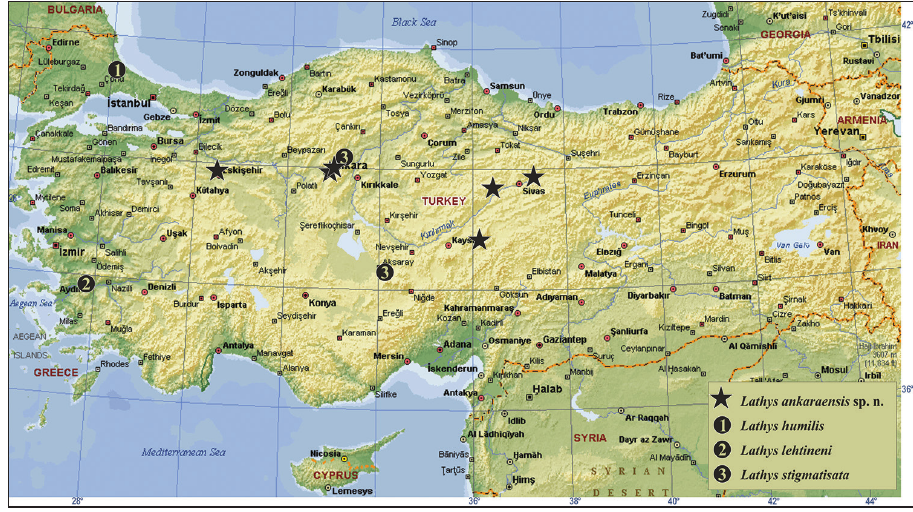
Figure 1. Distribution map of four Turkish Lathys